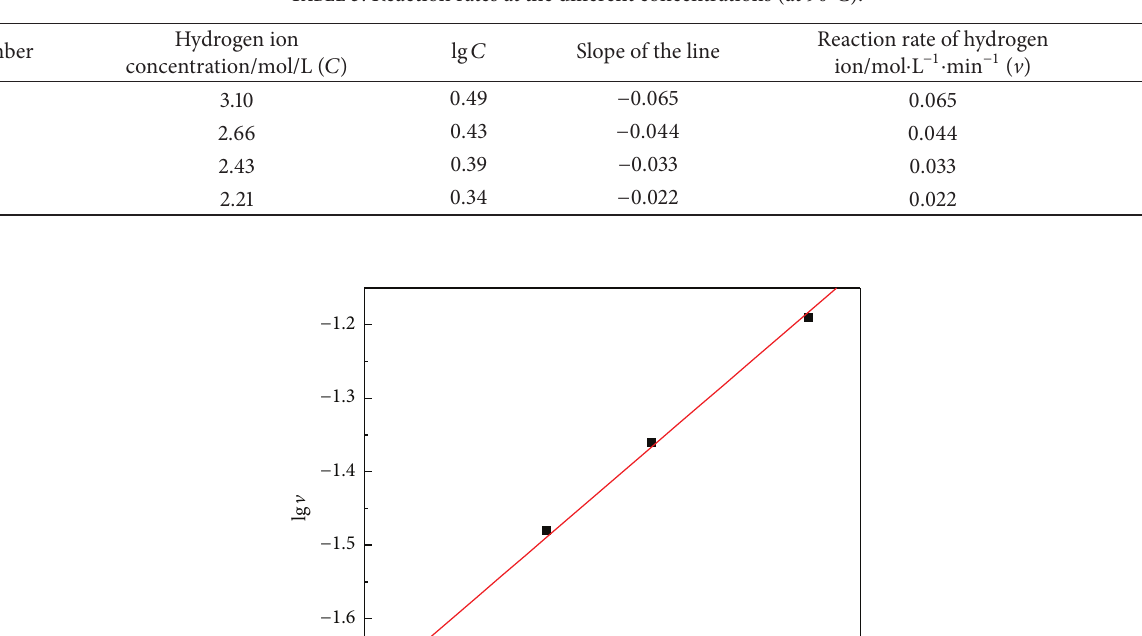
Table 5: Reaction rates at the different concentrations (at 90 ∘ C).